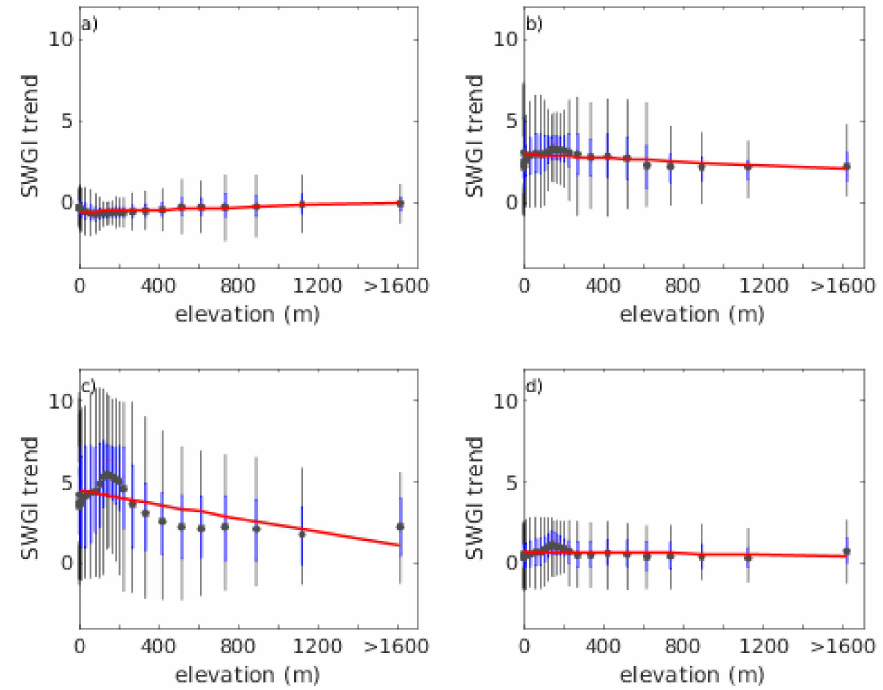
Figure 16. Box and whiskers plot of the SWGI seasonal trend (W/m 2 per decade), mean trend (black star), and the trend line (red line) for various bins of the elevation for ( a ) winter (DJF); ( b ) spring (MAM); ( c ) summer (JJA); and ( d ) autumn (SON). The lower boundary of the box indicates the 25th percentile, and the red line within the box marks the median and the upper boundary of the box indicates the 75th percentile. Whiskers above and below the box indicate the 90th and 10th